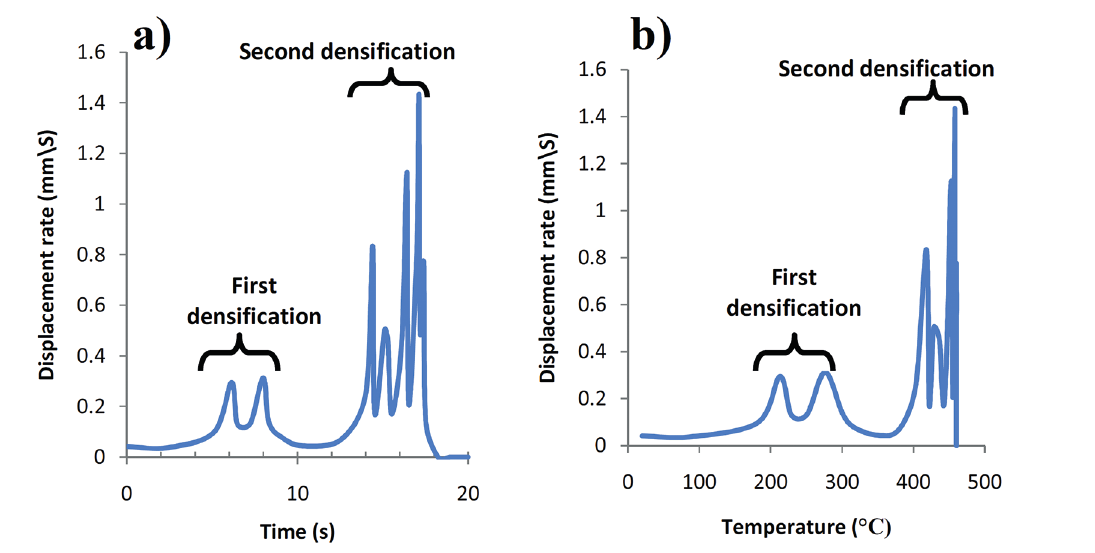
Figure 3: Displacement rate Vs time and temperature in sintering process.